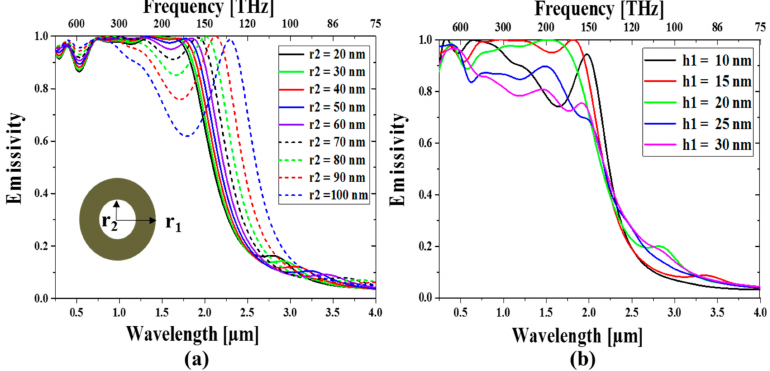
Figure 4. The influence of geometry on the emissivity at ( a ) various inner radius r 2 at h 1 = 15 nm, h 2 = 40 nm, h 3 = 120 nm, r 1 = 120 nm, n = 11 and Λ = 400 nm. Inset in ( a ) shows the top view of nano-ring, ( b ) various thickness of nano-ring h 1 at h 2 = 40